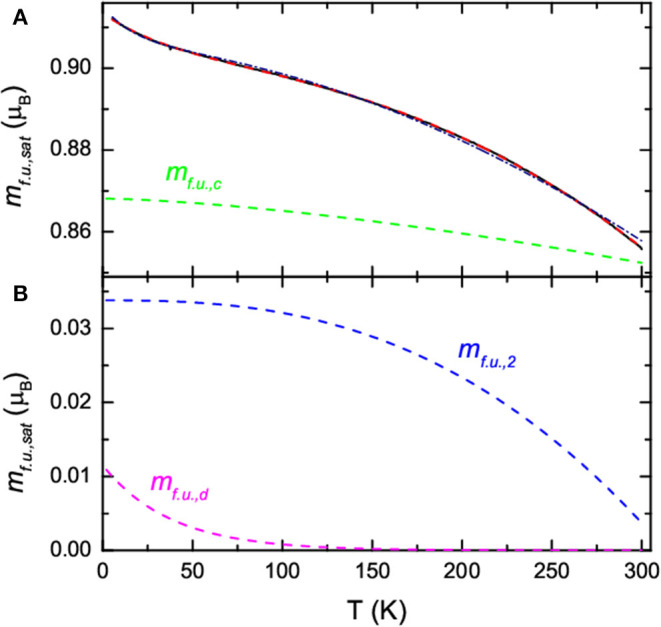
(A) Plot of the saturation moment per formula unit, mf.u,sat., against temperature at 5 K; (solid black curve) a fit to the data using Equation (2) (dot dashed navy curve) and Equation (3) (dashed red curve). The ordered core contribution to the fit, mf.u.,c, using Equation (3) is also plotted (dashed green curve). (B) Spin-disordered, mf.u.,d, (dashed magenta curve) and the 2nd contribution, mf.u.,2, (blue dashed curve) to the fit to the data in (A) using Equation (3).